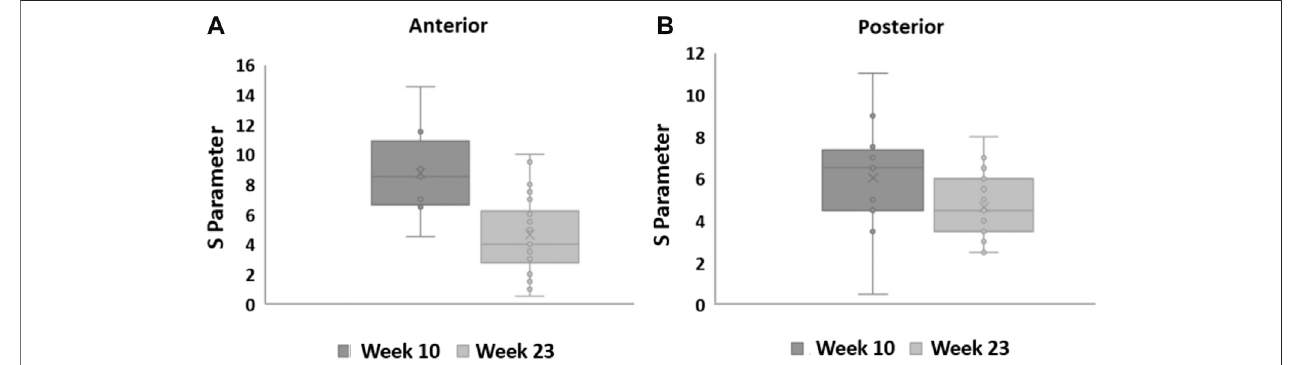
FIGURE10| Boxplotsforthe S parameterestimatedfrom invivo NHPSWEIdataatweeks10and23ofpregnancy.Thecentrallineandcrossindicatethemedian and mean, the top and bottom limits of the box represent the interquarrtile range, the wiskers indicate the range de fi ned as 1.95 times the interquartile range above and below the 25 and 75 percentiles, and the circles indicate values for each subject.